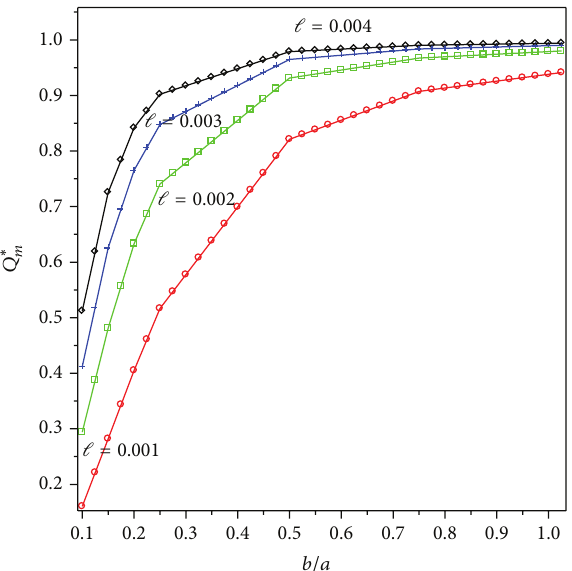
Figure 8: Influence of slip length on the flow rate 𝑄 ∗ 1 on the cross- section of the channel with the area of 1.0×10 −6 m 2 and ratio 𝑏/𝑎 of 1 under the frequency 𝜔 = 𝛼/𝜌𝑎 2 with 𝛼 = 0.005 at various instants of time.